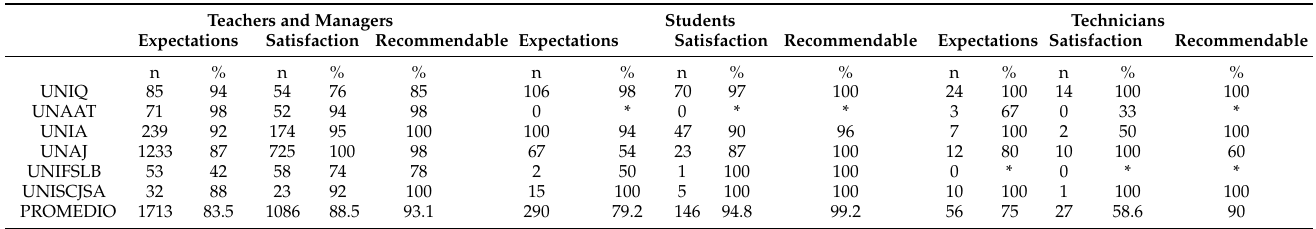
Table 7. Summary of the results from the expectation and satisfaction